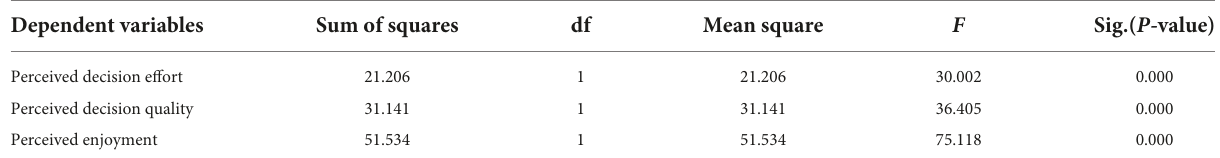
TABLE 10 Simple effect